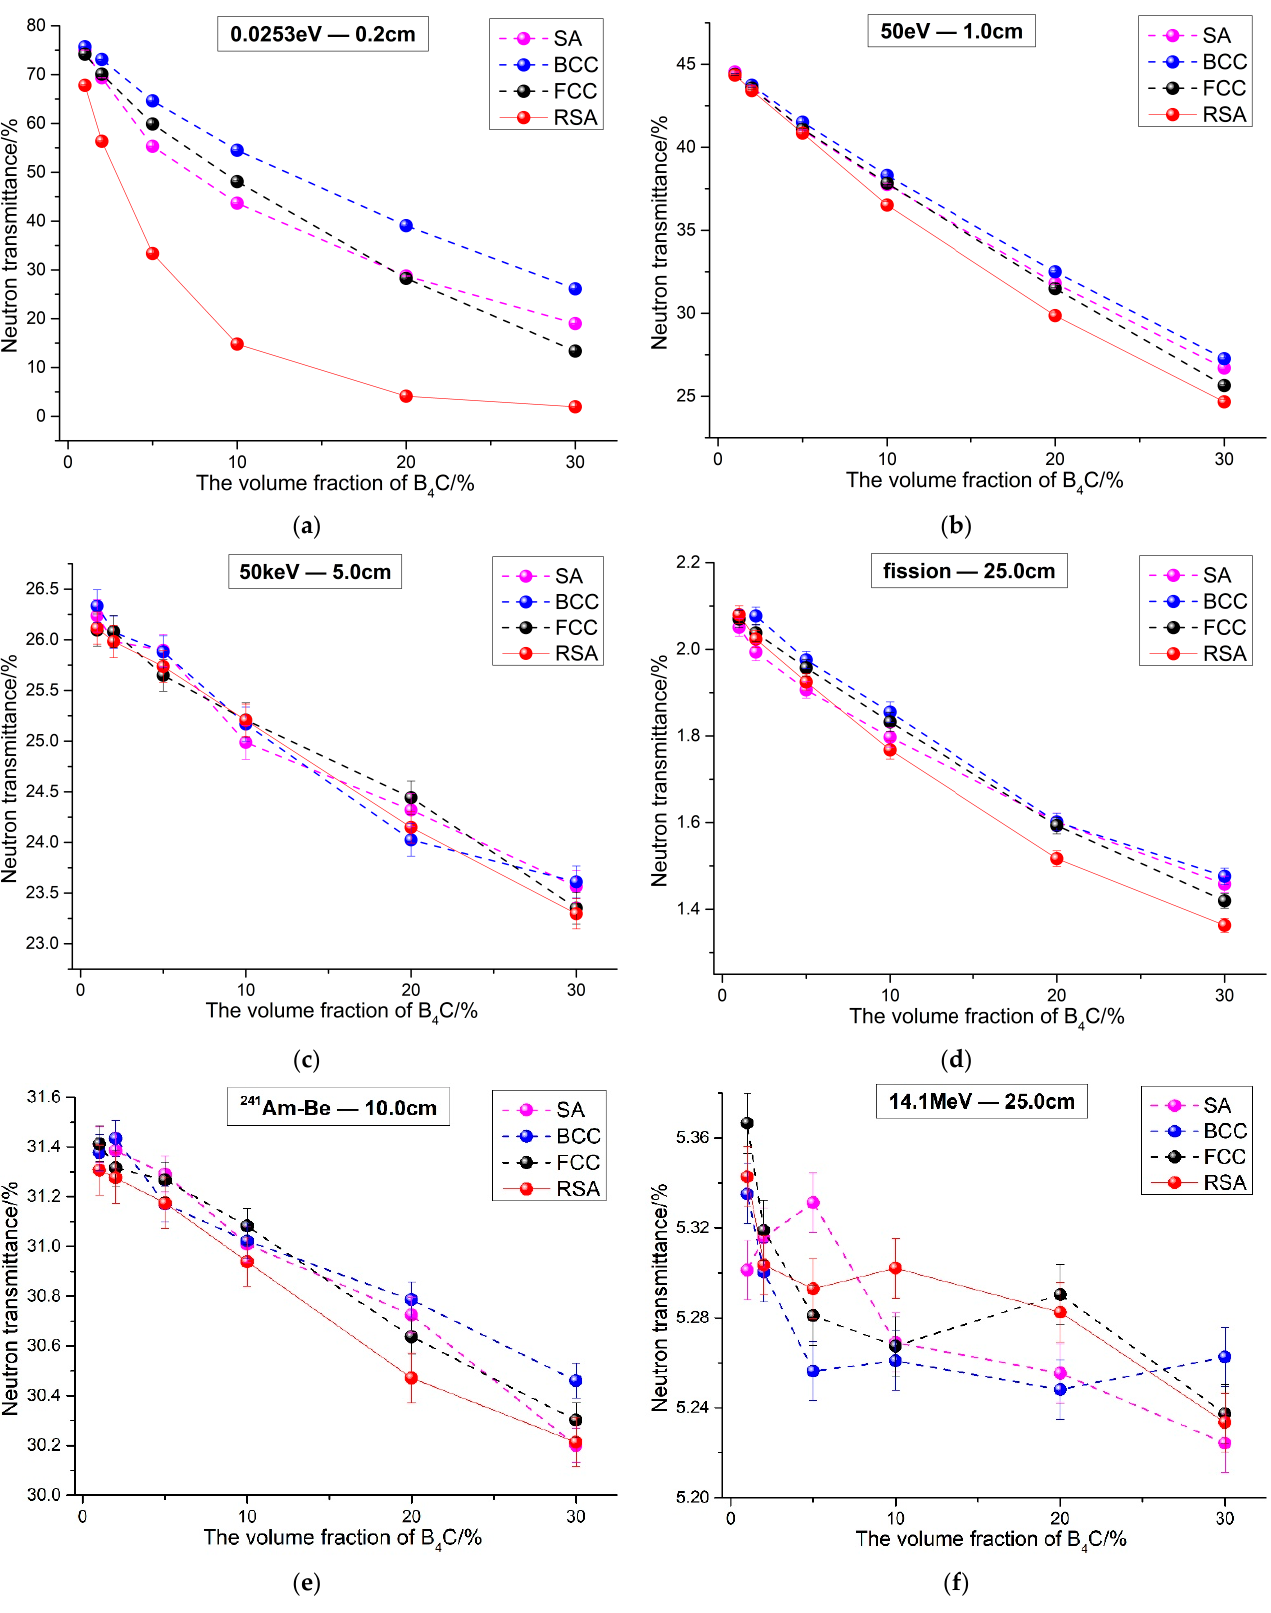
Figure 6. Neutron transmittance of B 4 C reinforced 316 stainless steel composites under different neutron energies. (( a ) 0.0253 eV; ( b ) 50 eV; ( c ) 50 keV; ( d ) fission spectrum; ( e ) 241 Am-Be spectrum; ( f ) 14.1 MeV).